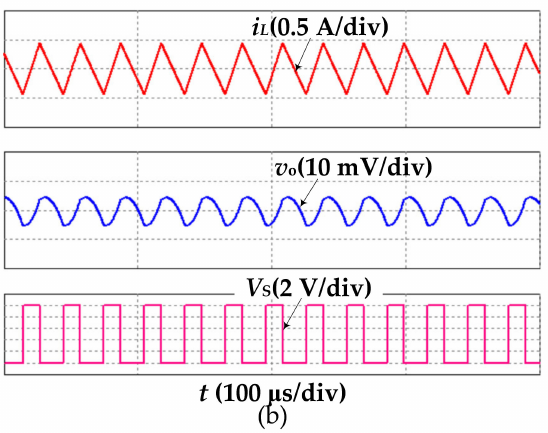
Figure 3. Steady-state simulation results for two COT controls with output capacitor ESR r = 10 m Ω .